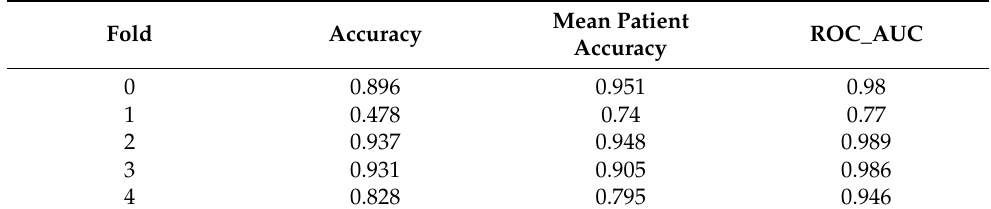
Table 4. Experiment 4—Identification of colonic ulcerated mucosa.